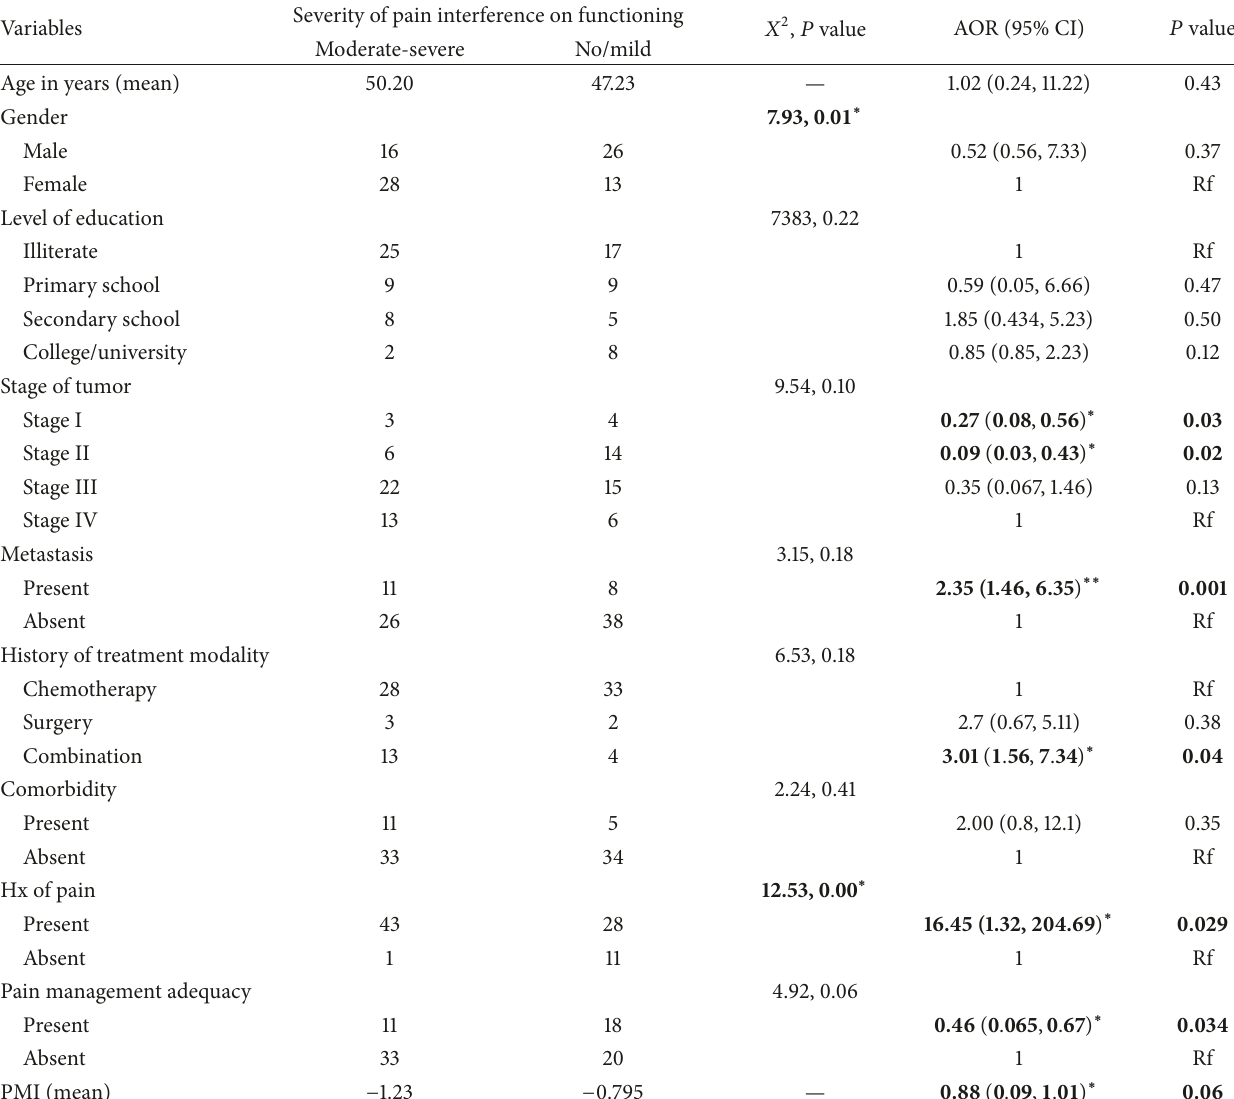
Table 4: Relationship between predictive variables and severity of pain interference on functioning at Gondar University Hospital, Gondar,